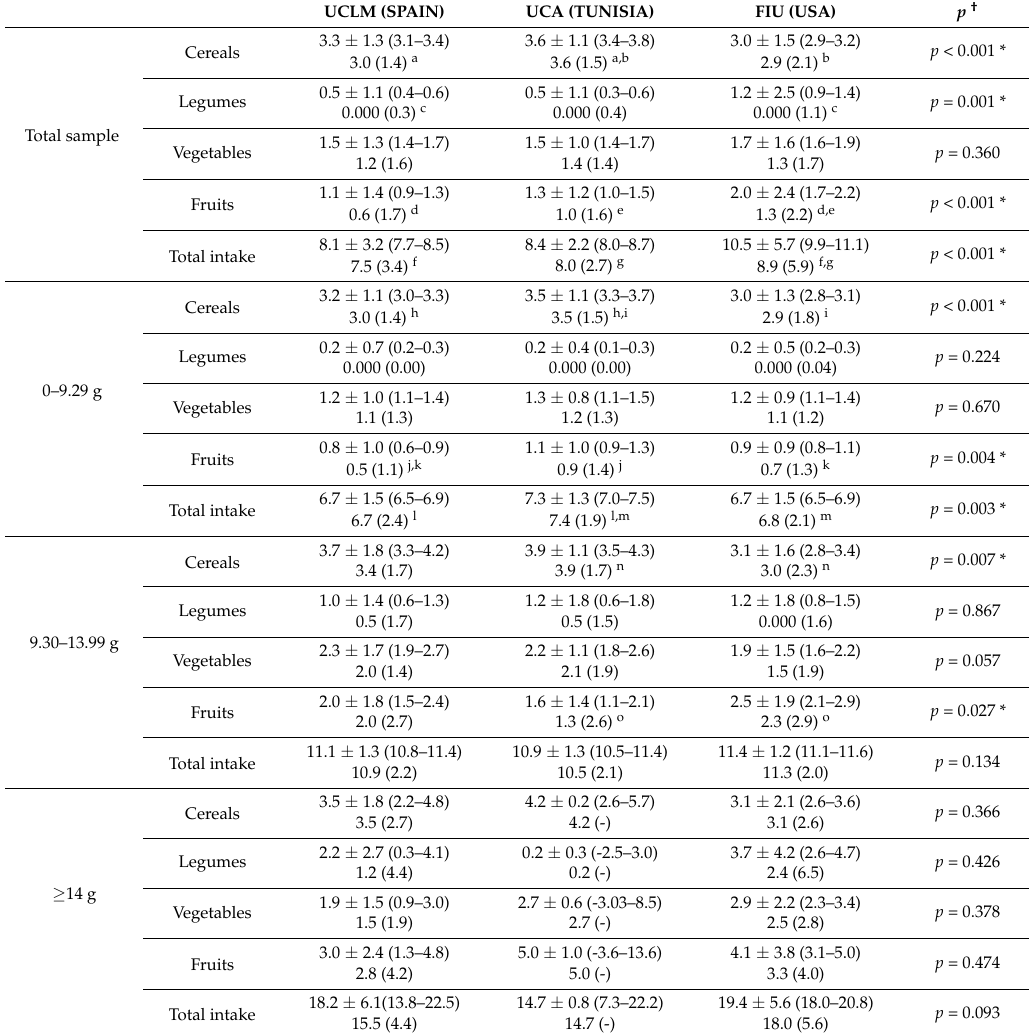
Table 5. Fiber intakes (g/1000 Kcal) from the main food groups providing fiber §